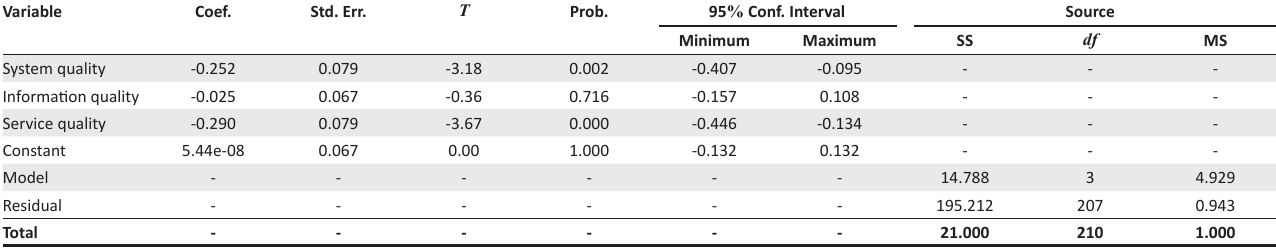
TABLE 3: Regression model for user satisfaction. Variable Coef.